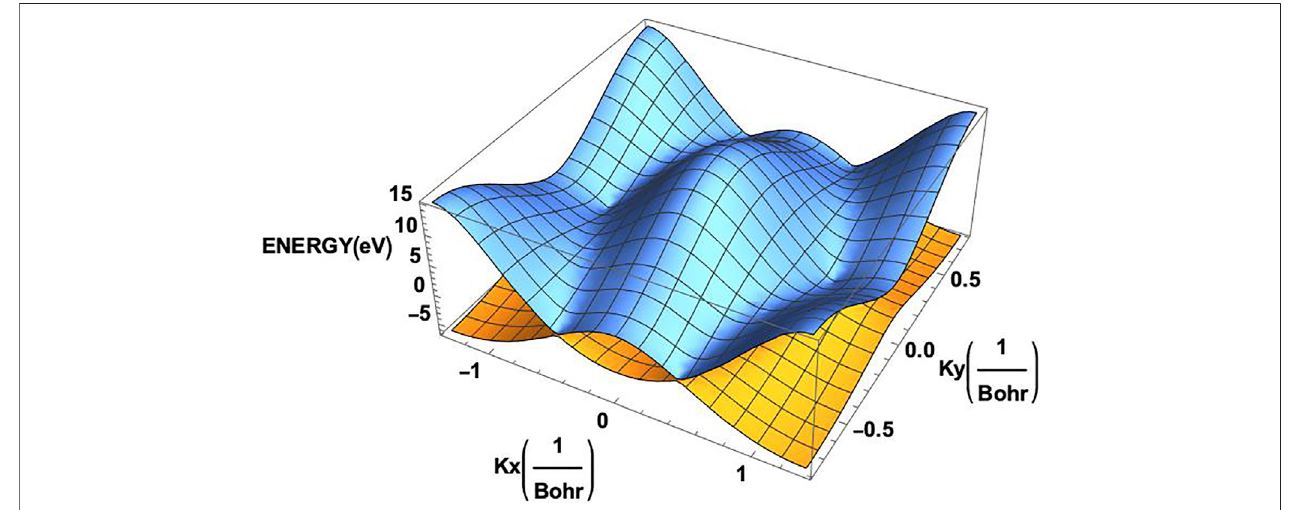
FIGURE 3 | Two dimensional band structure of the monolayer graphene. The valence band (orange) and the conduction band (blue) clearly exhibit the corners of the hexagonal Brillouin zone on them.